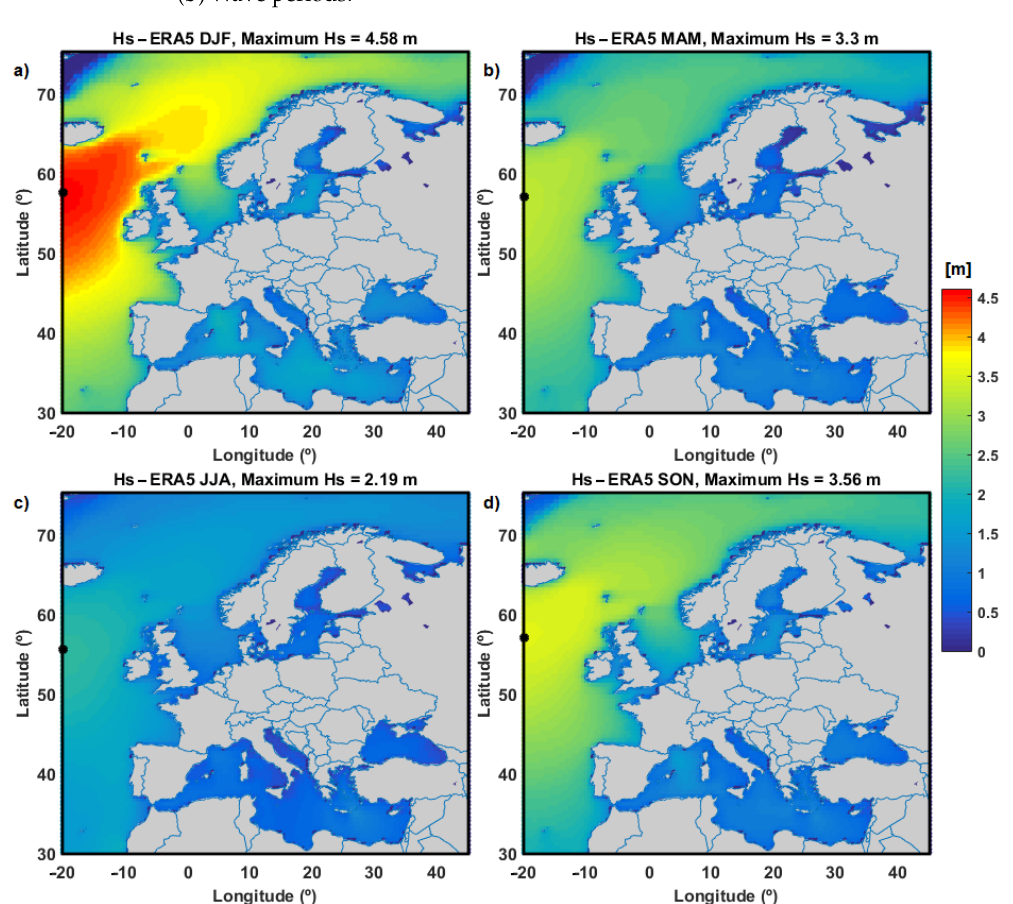
Figure 15. Seasonal variability of the mean significant wave height over the 20-year time interval (from 2001 to 2020) based on ERA5 data: ( a ) winter (DJF), ( b ) spring (MAM), ( c ) summer (JJA), ( d ) autumn (SON).